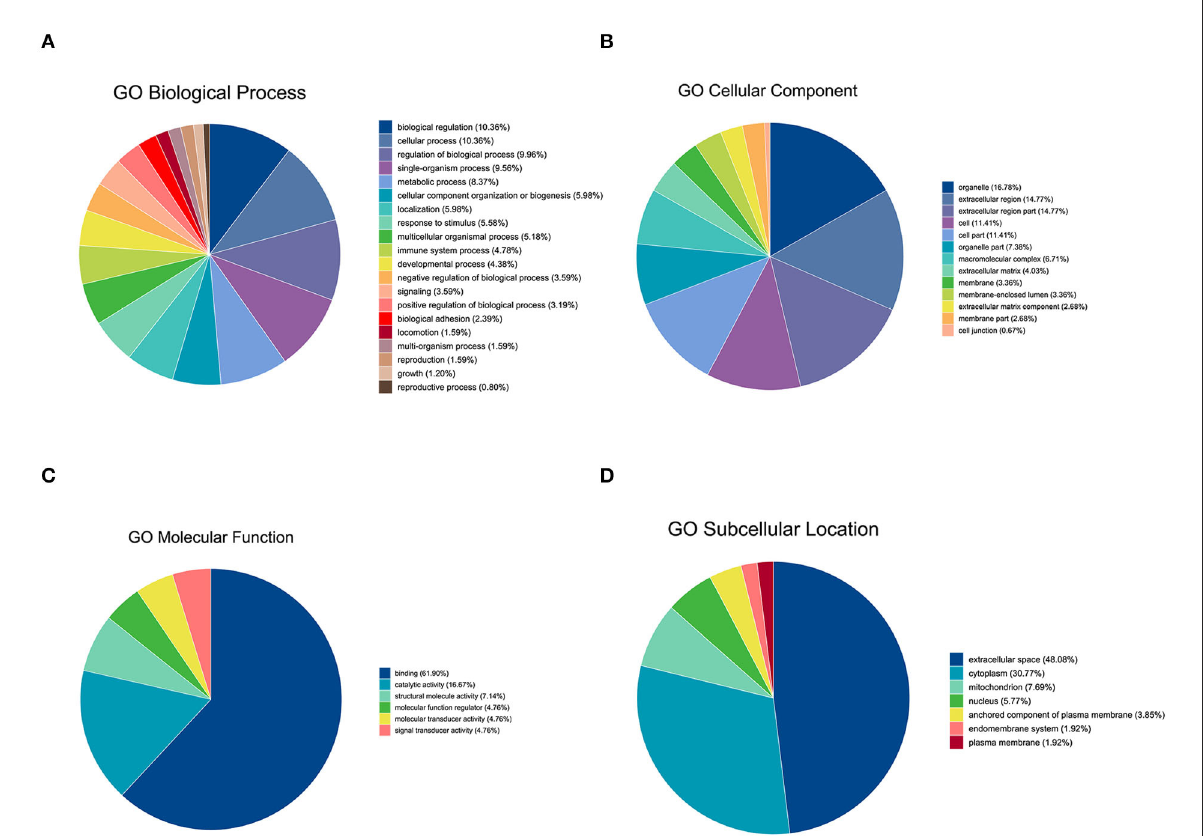
FIGURE2 GO analysis of significantly differential proteins between DHD calves and clinically healthy calves. (A) Biological process-based analyses of significantly different ial proteins. (B) Cellular component-based analyses of significantly different ial proteins. (C) Molecular function-based analyses of significantly different ial proteins. (D) Subcellular location-based analyses of significantly different expression